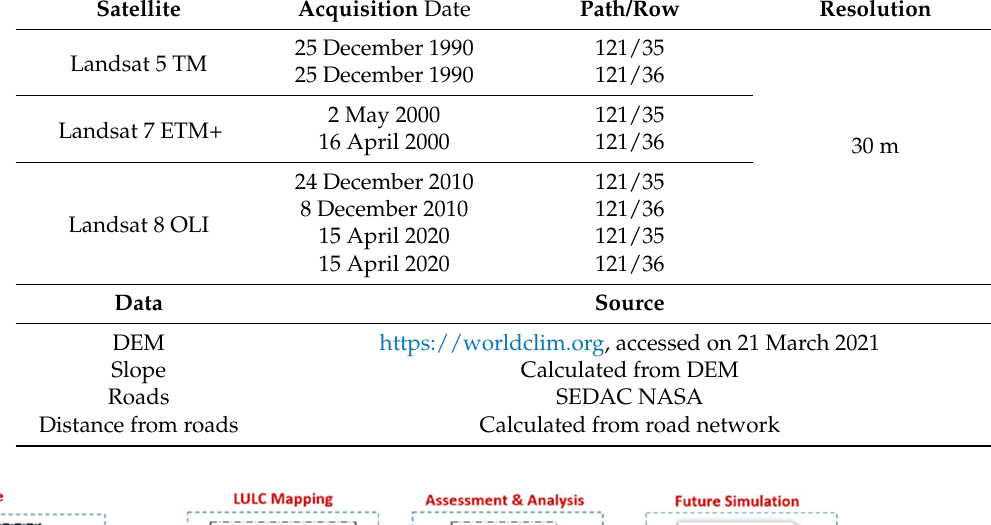
Table 1. Data sources.